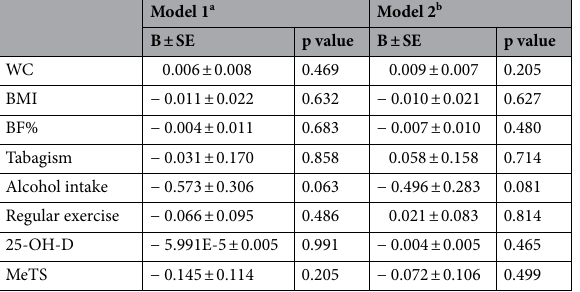
Table 3. Linear regression analysis of lifestyle/environmental factors with log 10 AMH in participants (n = 177). a Model 1—adjusted for SRA. b Model 2—adjusted for SRA and age.